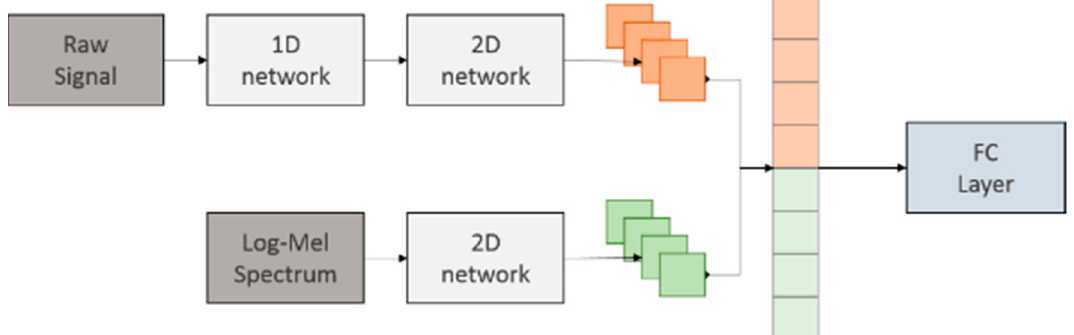
Figure 2. Parallel architecture of the network.